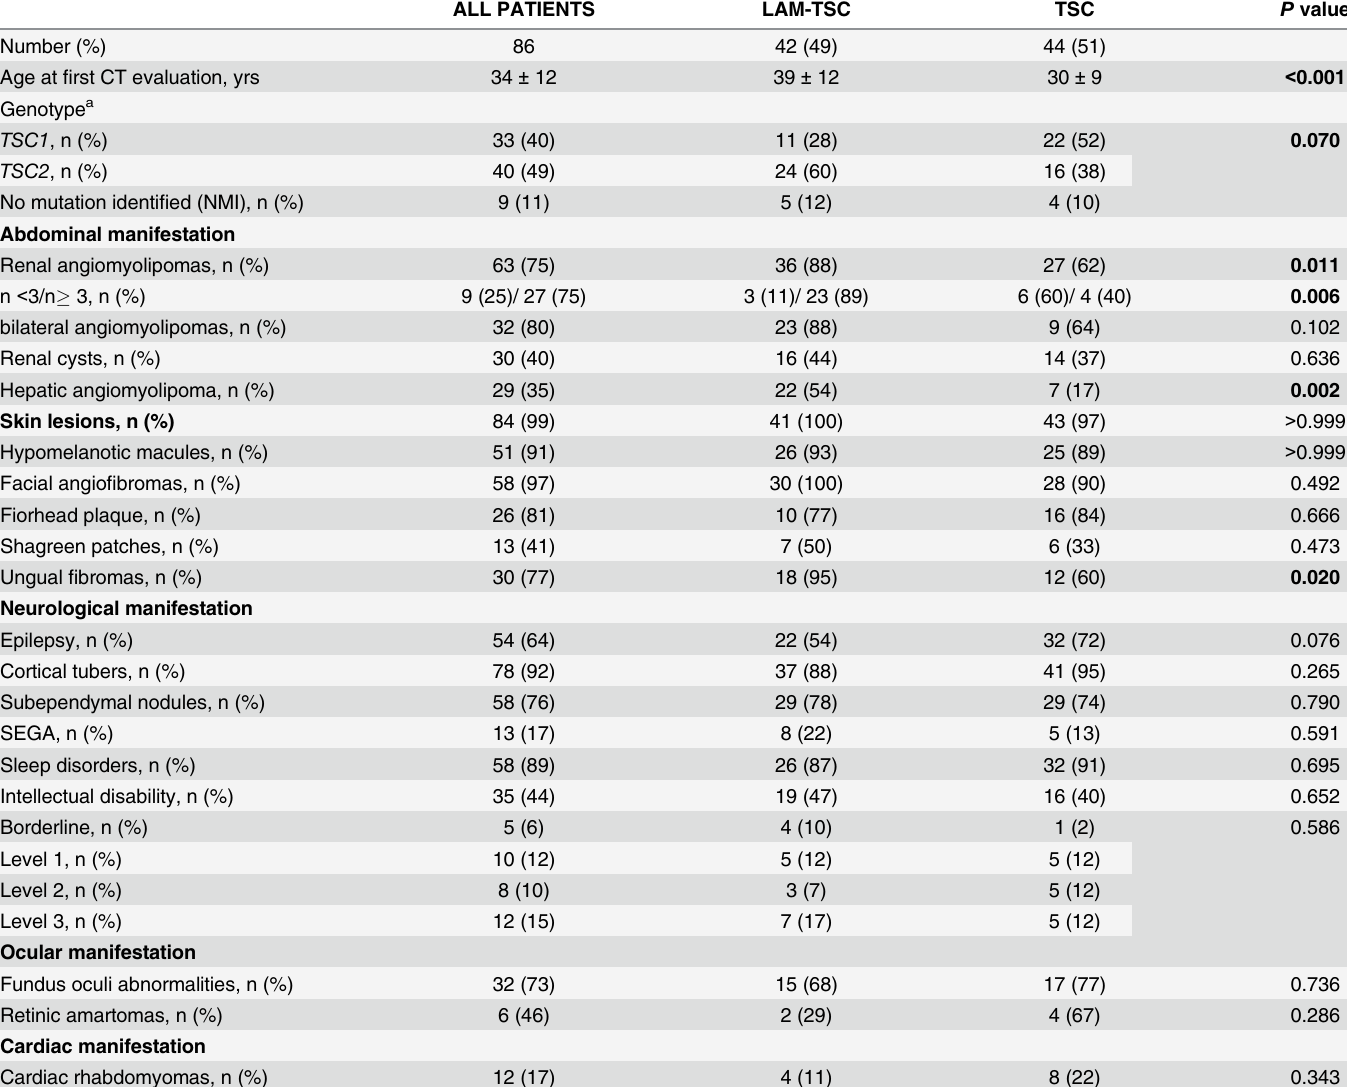
Table 1. Demographic and clinical characteristics of enrolled patients according with LAM. ALL